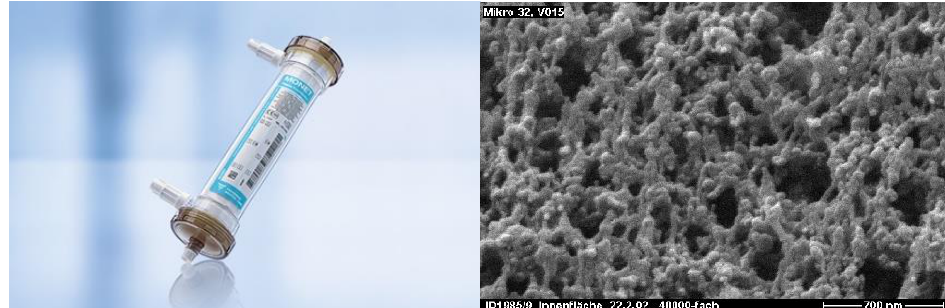
Figure 3. Illustration of MONET ® plasmafilter (left, Fresenius Medical Care ® educational materials) and a microscopic view of its pores (right, adapted with permission from Rimmelé et al. [13]) used in plasmapheresis: the diameters of pores should be approximately 0.2–0.6 micrones, the total filtration surface of plasmafilter of 0.3–0.6 m 2 and for molecules with a mass of 15 kDa–2 MD, the permeability ratio should be of high value.